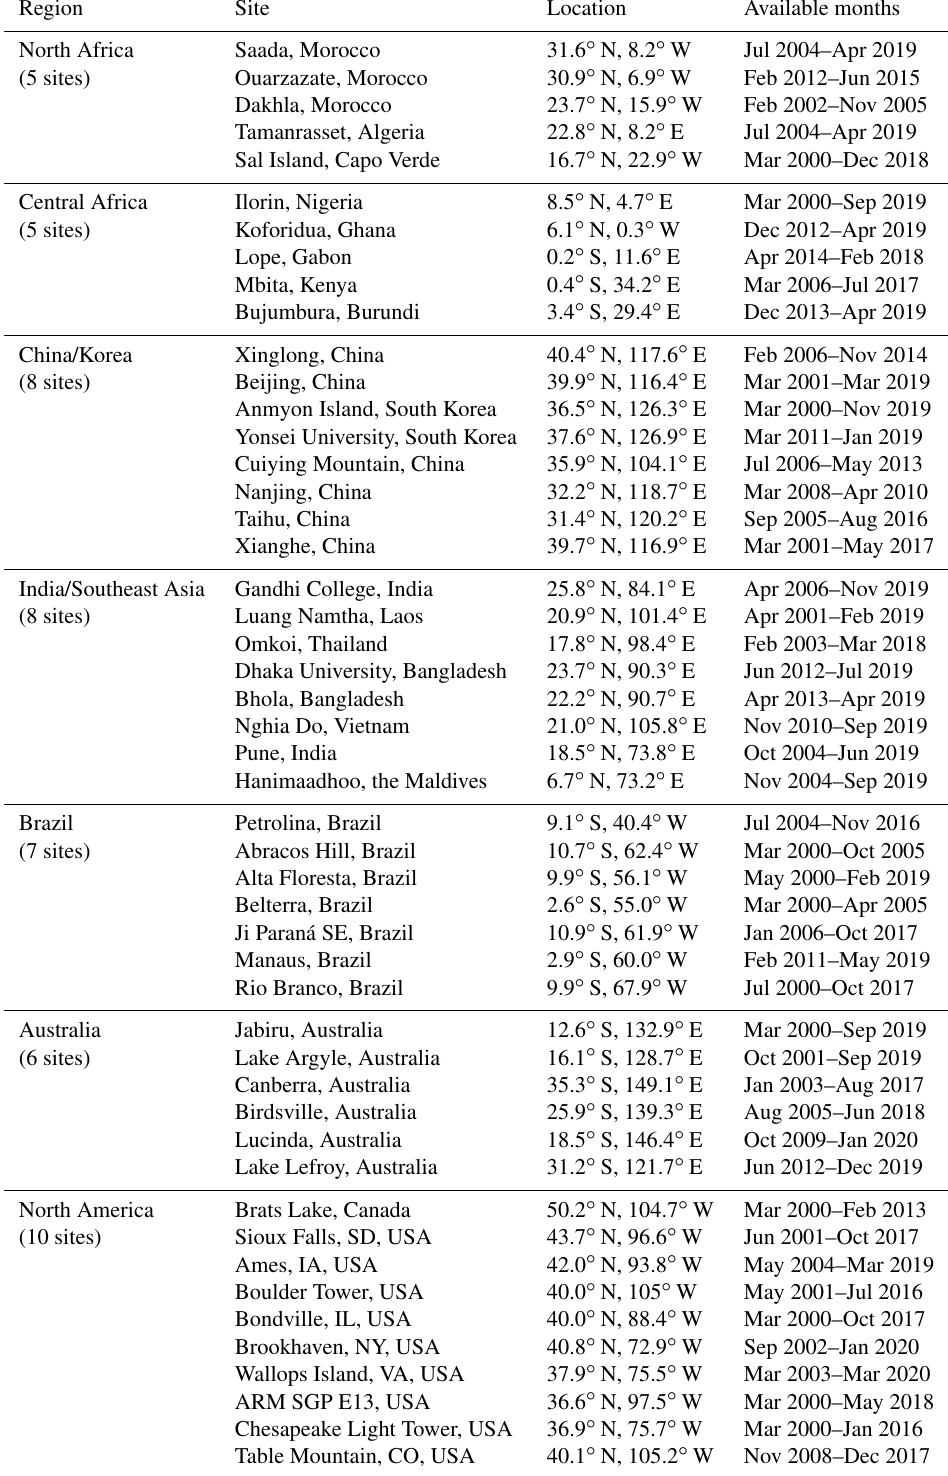
Table A1. AERONET observation sites. Region